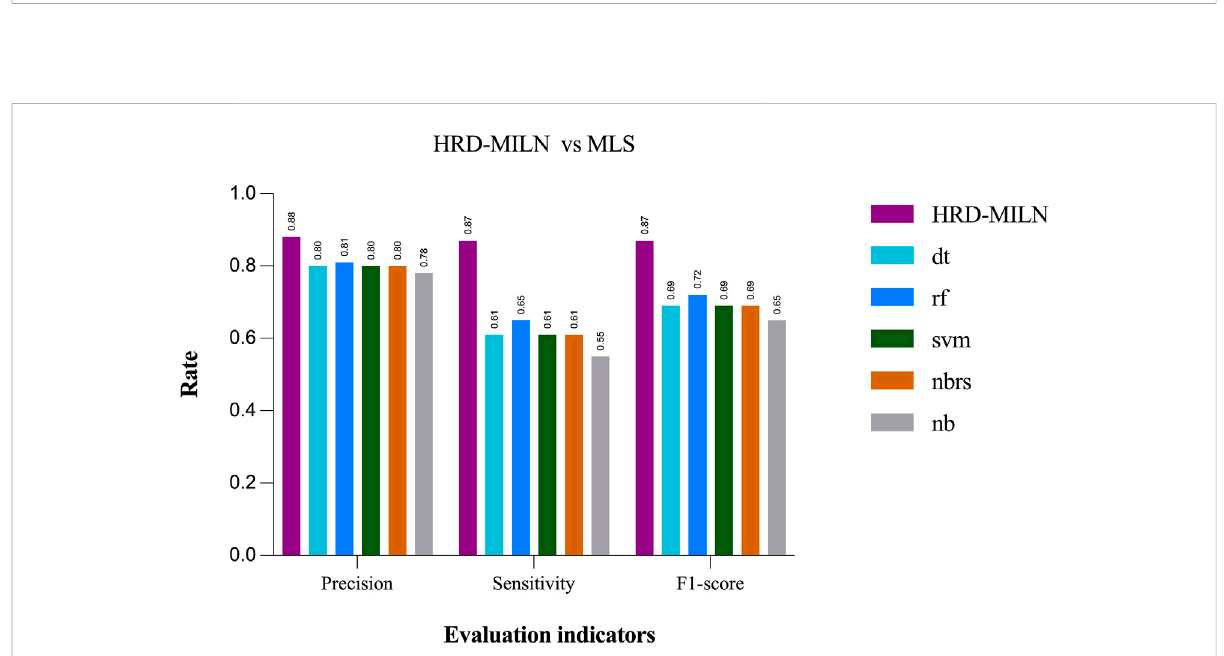
FIGURE 4 The performances ofMILSand HRD-MILNin panel sequencing samples. HRD-MILN had the highestscores (precision 0.88, sensitivity 0.87, F1- score0.87)thanMILSoneachEvaluationindicator.Abbreviations:MLS:machinelearnings,dt:DecisionTree.rf:RandomForest.svm:SupportVector Machine. nbrs: KNeighbors. nb: